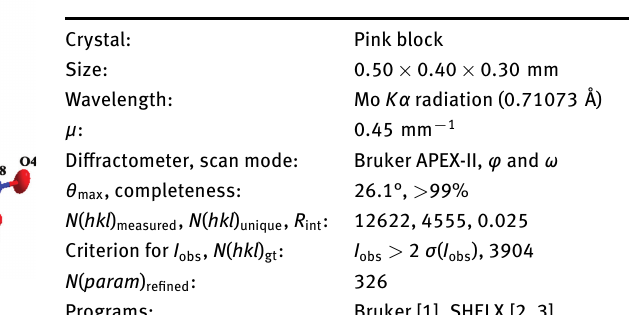
Table 1: Data collection and handling.